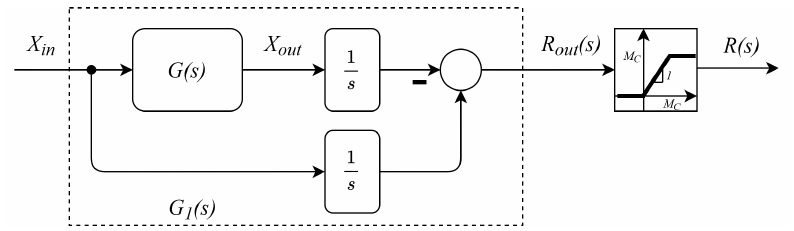
Figure 3. Model structure for vehicle load on a single-lane road